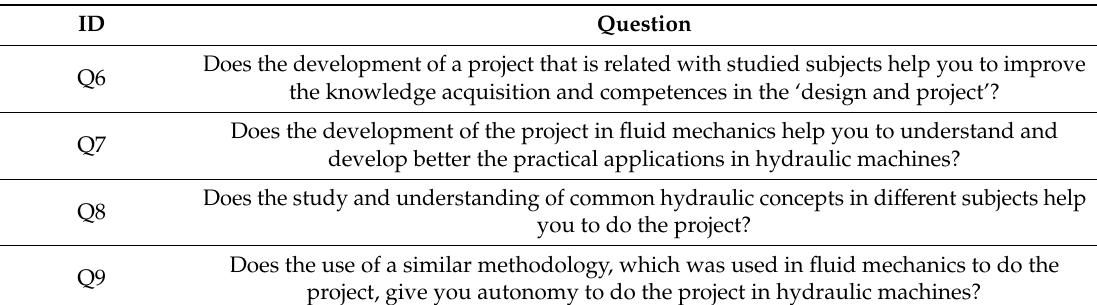
Table 4. Questions related to coordination between